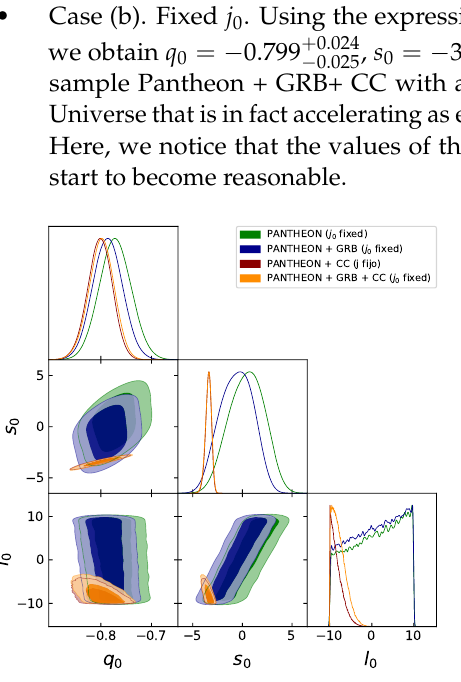
Figure 2. Case (b) using Pantheon compilation (green C.L.), Pantheon+GRB (blue C.L.), Pantheon+CC (red C.L.) and Pantheon+GRB+CC (orange